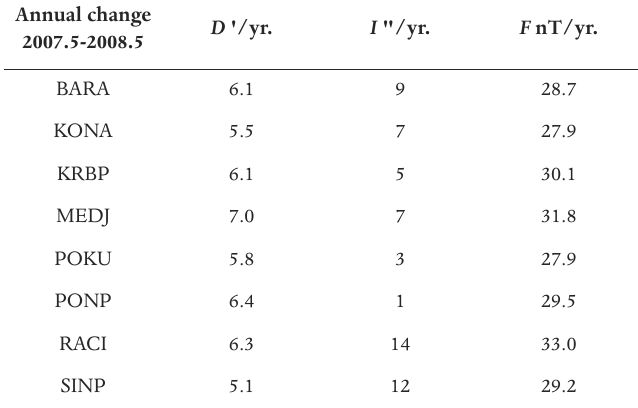
Table 3. The annual change in the period from 2007.5 to